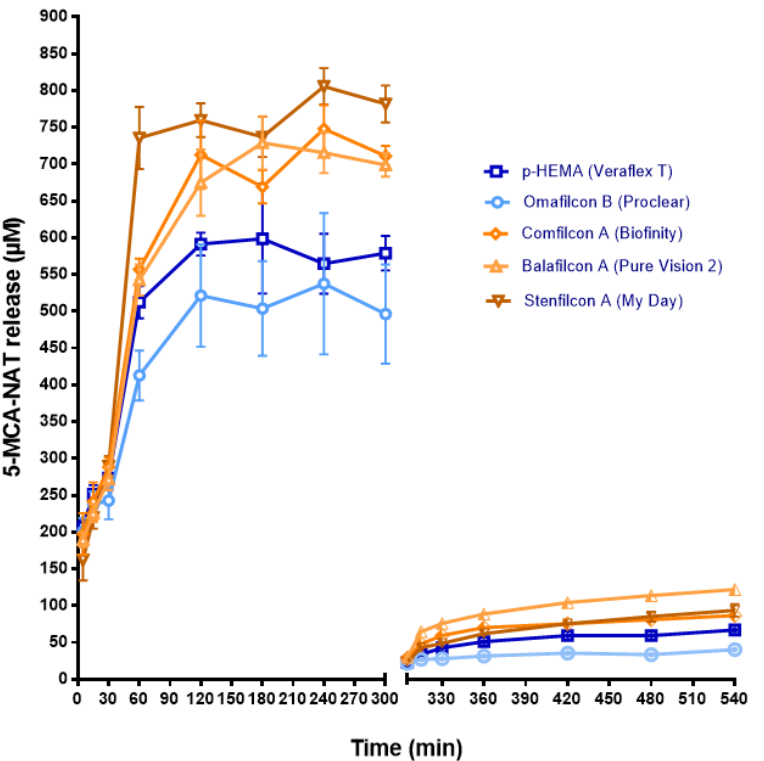
Figure 4. The 5-MCA-NAT release from CLs previously soaked with the 5-MCA-NAT solution (1 mL, 1 mM) for 12 h to a saline solution (1 mL) over 540 min, with a change in the saline medium at 300 min. The concentration ( µ M) values are presented as the mean ± S.D of n = 9 lenses per material. The blue color shows the release from CH CLs. The ochre color shows the release from SH CLs.